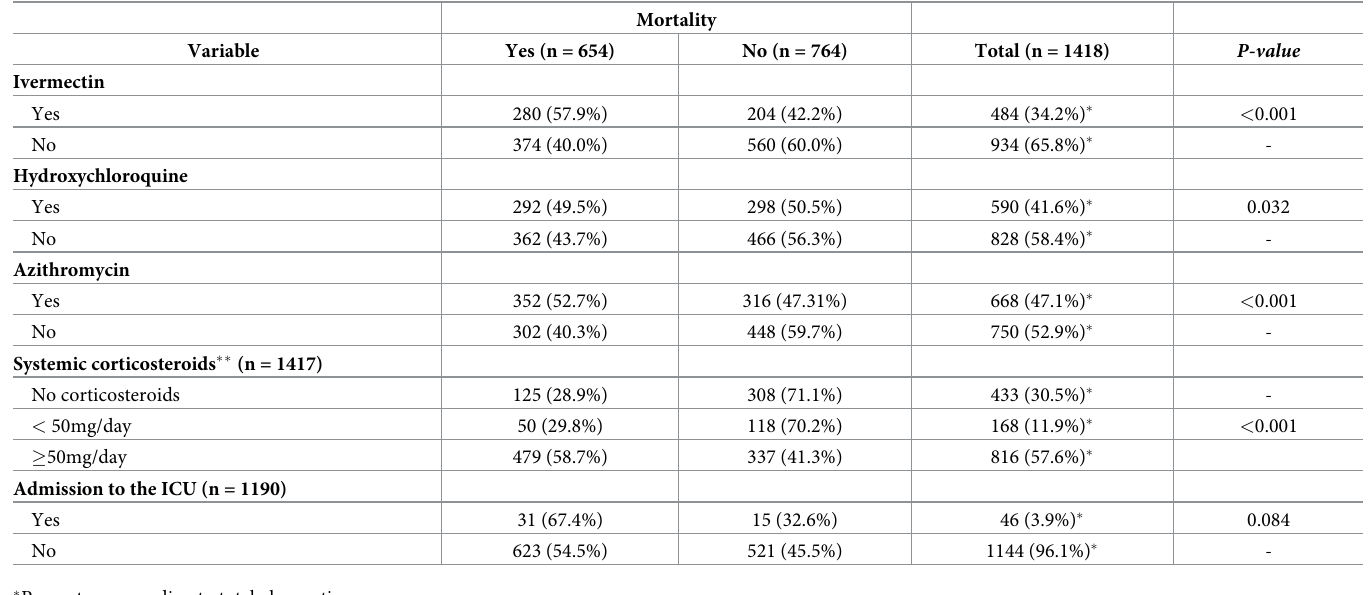
Table 5. Treatment in patients with COVID-19 admitted to the Hospital Nacional Hipo´lito Unanue from April to August 2020. Lima, Peru.